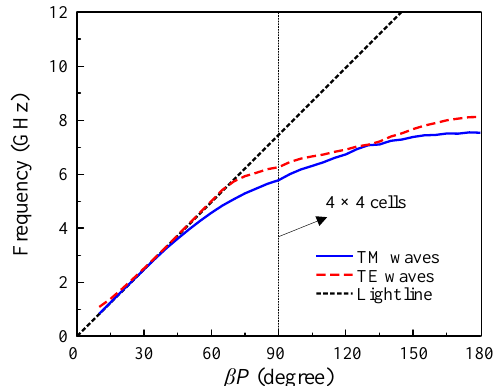
Figure 2. Dispersion diagram of the metasurface (MS) unit cell. TM: transverse magnetic; TE: transverse electric.